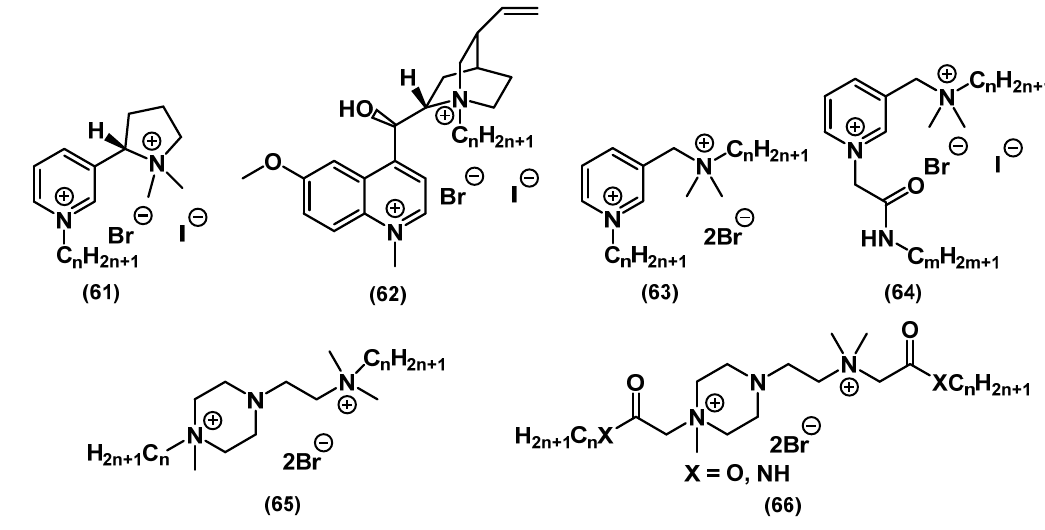
Figure 23. Mixed bis-QACs.